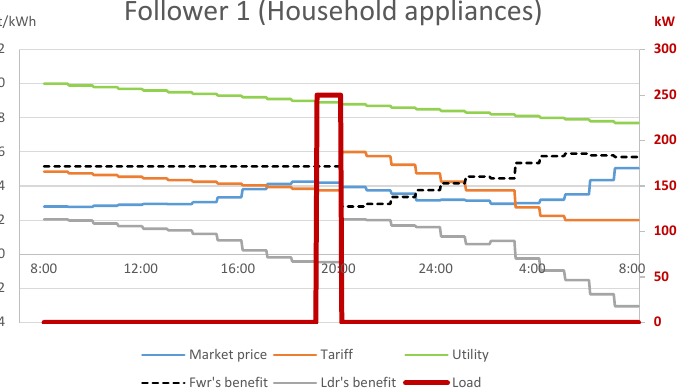
Figure 4. Optimistic tariff with the least favorable follower response: grid-level consumption.